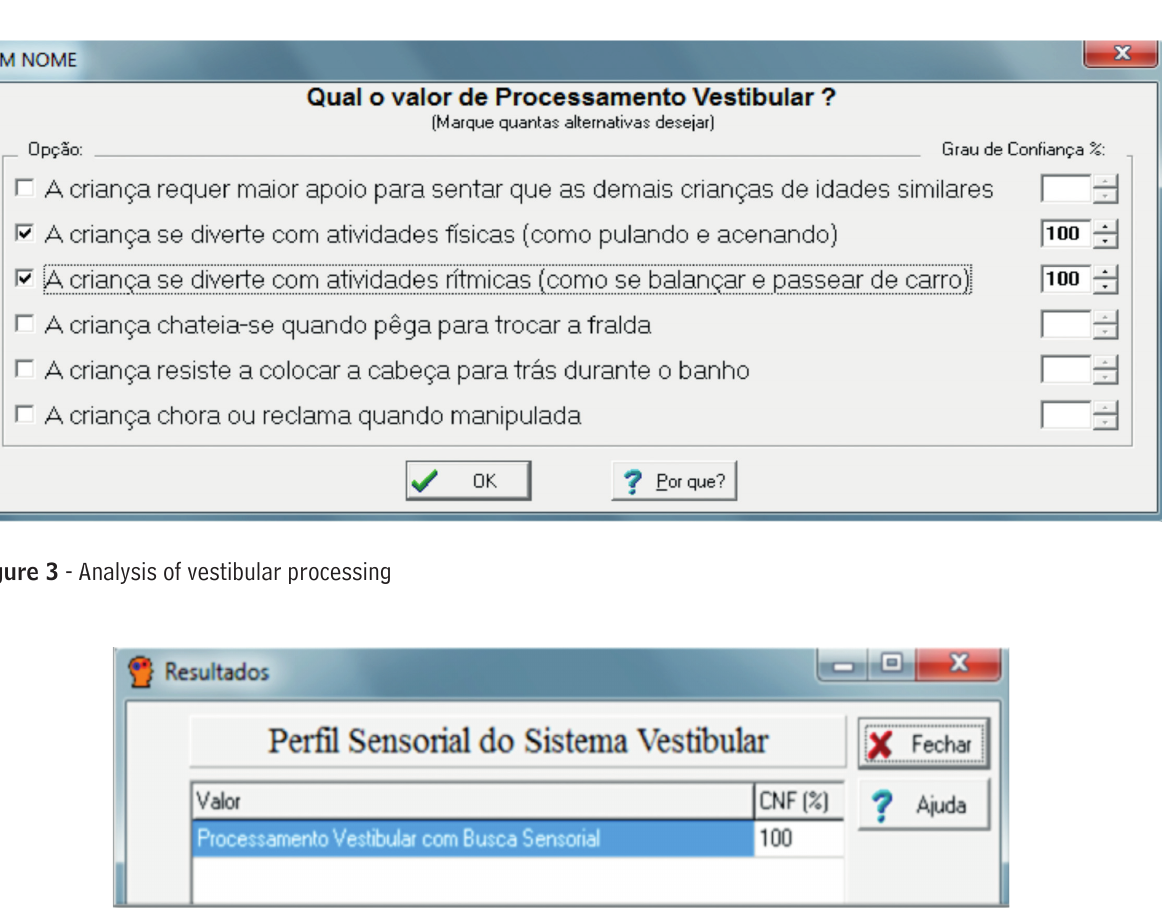
Figure 4 - Sensory profile resulted from the processing